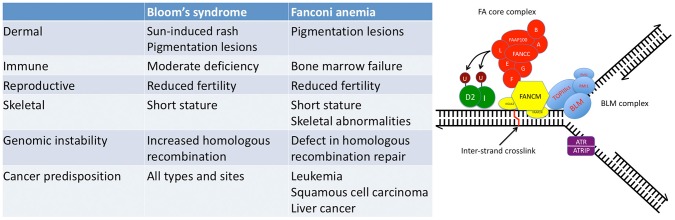
Fanconi anemia (FA) and Bloom's syndrome (BS) overlap at the clinical and molecular levels.Left panel: Comparison of the clinical and cellular features present in FA and BS. FA and BS have features that are distinct to each syndrome; however, there are broad similarities. Some individuals with mutations in BLM have been diagnosed with FA, exhibiting classical FA features. Right panel: Depiction of a super-complex that is formed at sites of repair of replication forks that have been impeded by an inter-strand crosslink. The super-complex consists of two complexes that form independently in the nucleus. One complex consists of the interacting proteins identified through FA mutations and the other complex consists of proteins that interact with BLM, the gene mutated in BS [33]. These two complexes are brought together by mutual interactions with the FA gene product FANCM [34]. Molecular interactions between FANCJ and BLM at stalled forks have also been described [35]. Downstream signaling effects (FAND2 ubiquitylation and ATR activation) are also depicted. Figure was redrawn from Deans and West [34].